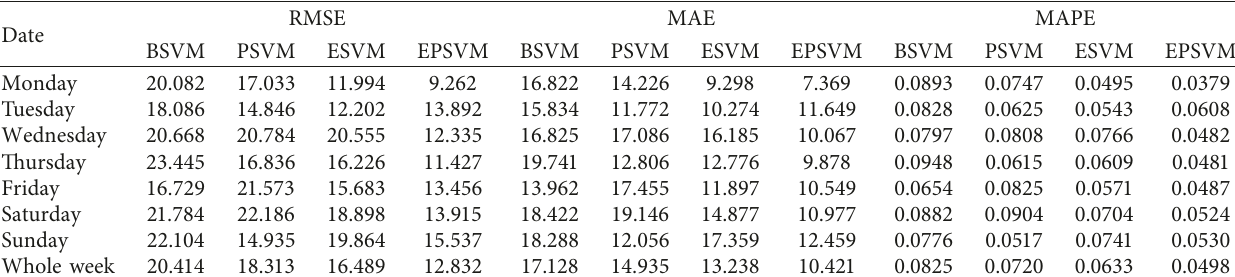
Figure 8: Forecasting result of outflow NTD at LZU network center: (a) Monday, (b) Tuesday, (c) Wednesday, (d) Thursday, (e) Friday, (f) Saturday, and (g) Sunday. Table 1: The result of evaluation metrics of the four forecasting methods (inflow